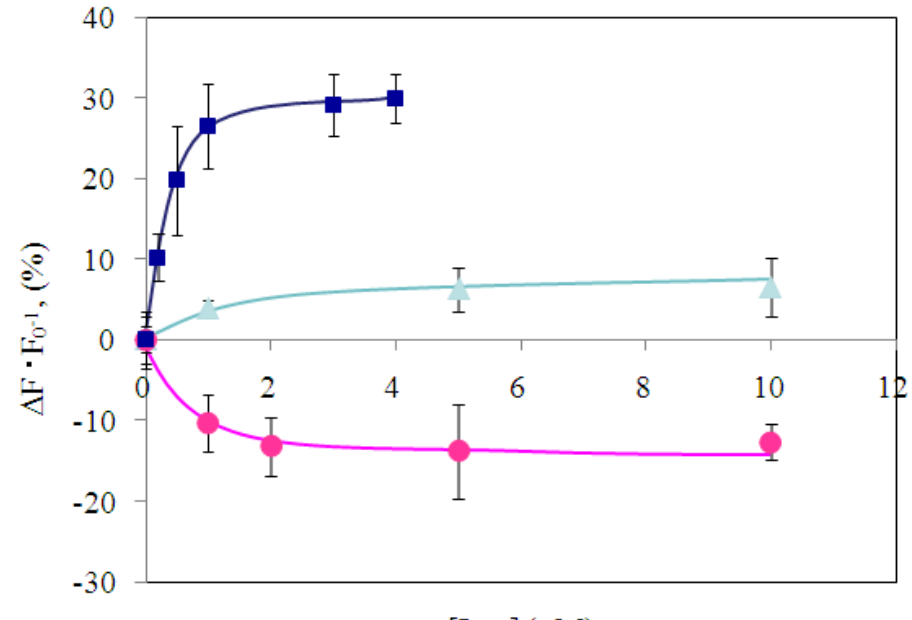
Figure 4. Correlation between fluorescence intensity change and Leu concentration for fluorophore modified-LIVBPs. The fluorescence intensity changes of fluorophore modified-LIVBP at a final concentration of 1.2 µM at 434 nm for Gln149Cys-M (filled square ■ ) and Gln254Cys-M (circle ● ), and at 517 nm for Gln149Cys-Ac (triangle ▲ ) were determined at different Leu concentrations. Error bars indicate SD ( n